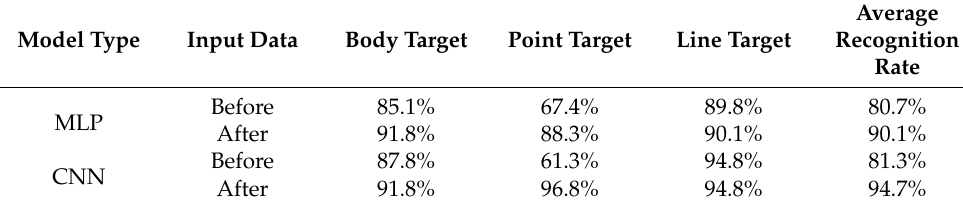
Table 4. Comparison of data enhancement